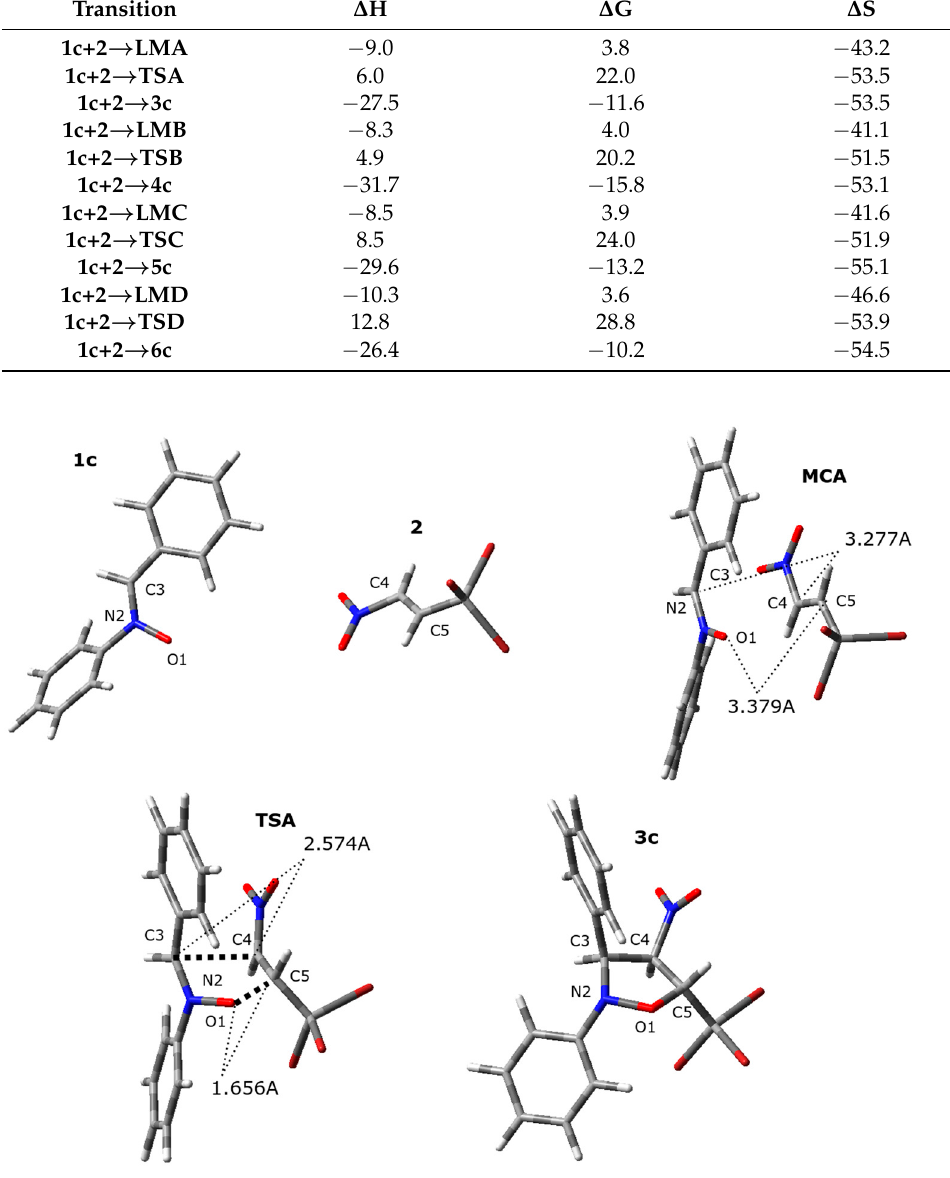
Figure 1. Views of critical structures for reaction 1c+2 → 3c in light of the wb97xd/6-311+G(d) (PCM) calculations . Table 2. Key parameters for critical structures for reaction 1c+2 → 3c in in light of the wb97xd/6- 311+G(d) (PCM) calculations.